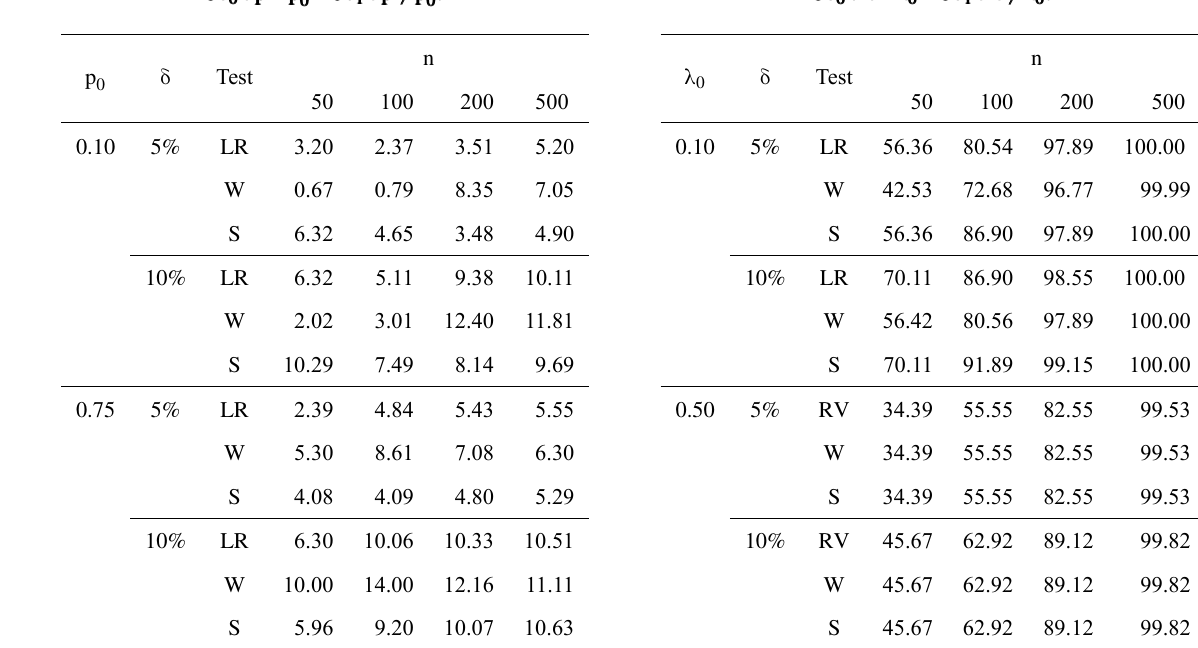
Null rejection rates (%), ZOIK distribution, H